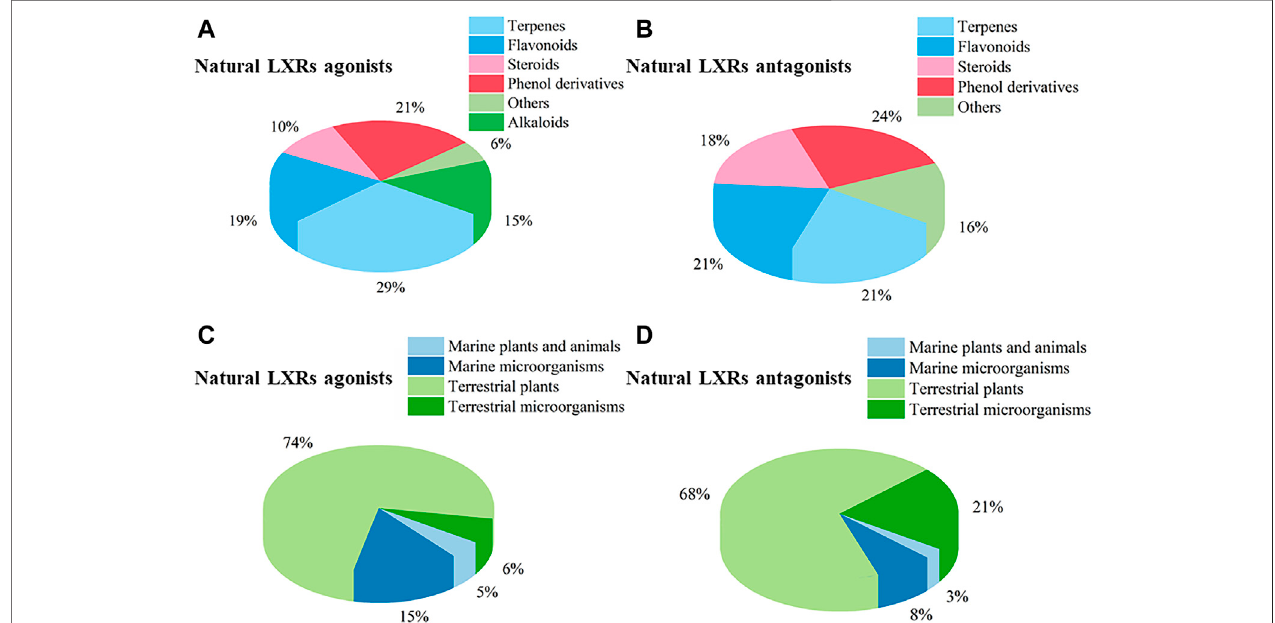
FIGURE 4 | Chemical types (A, B) and resources (C, D) of natural-derived LXRs agonists and antagonists.